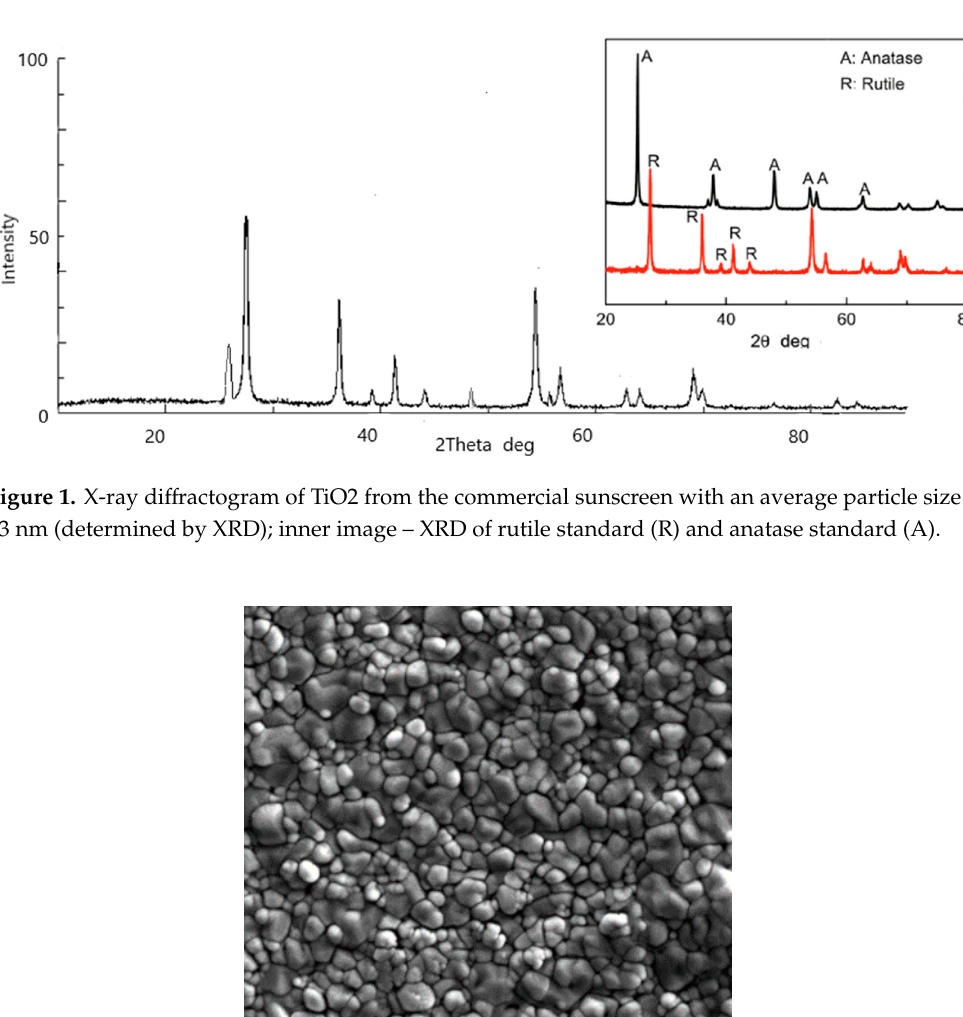
Figure 2. Scanning electron microscopy (SEM) micrograph of particles (after separation of the sunscreen base by extraction) present in the commercially available nanoTiO 2 sunscreen. Magnification bar = 100 nm.